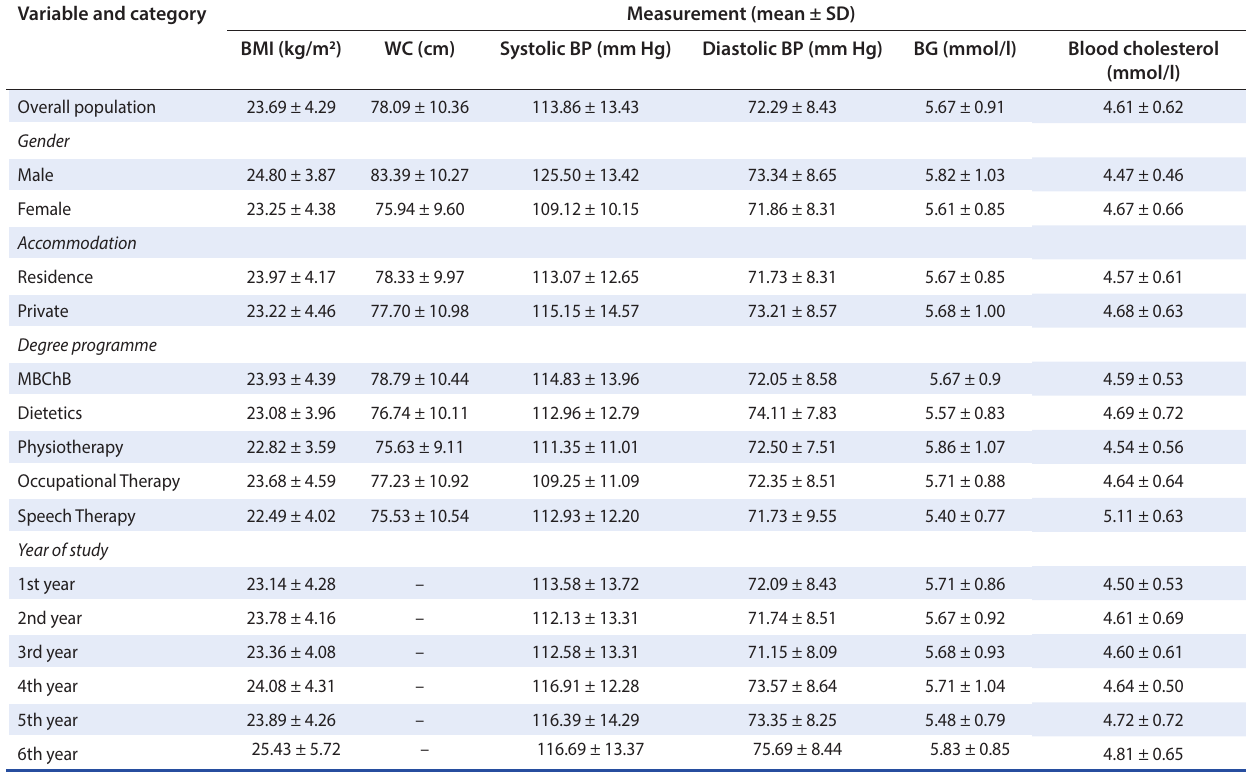
*Bold variables indicate statistically significant findings between various groups. SD = standard deviation; BMI = body mass index; WC = waist circumference; BP = blood pressure; MBChB = Bachelor of Medicine and Surgery; BG = blood glucose.